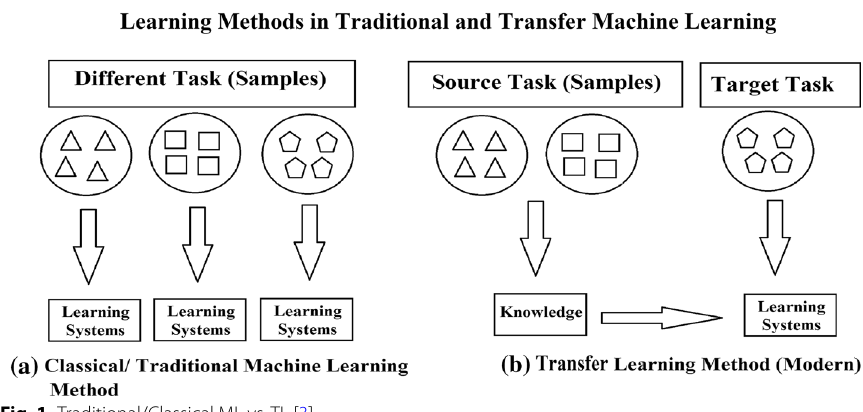
Fig. 1 Traditional/Classical ML vs. TL